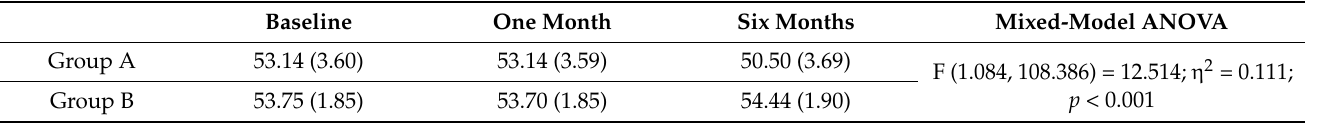
Table 3. Best-corrected visual acuity changes over